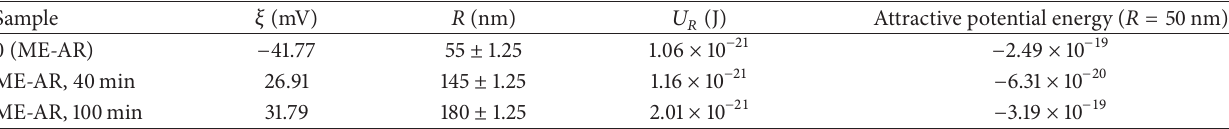
Table 8: The electric repulsive potential energy between